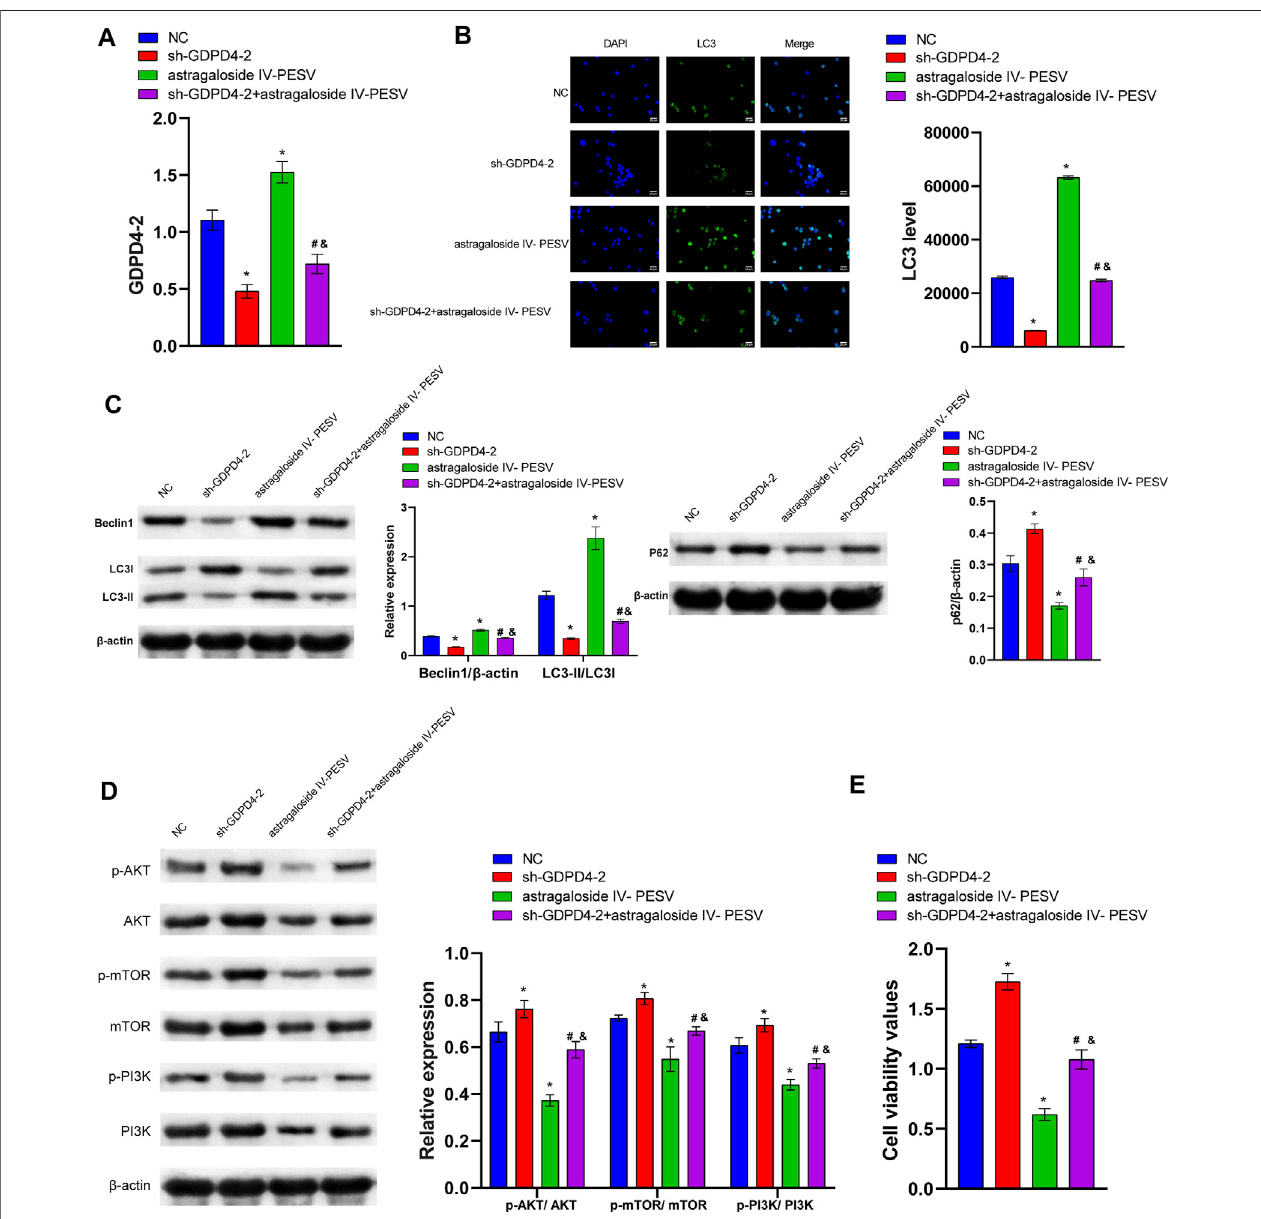
FIGURE 5 | Astragaloside IV- PESV regulated PI3K/AKT/mTOR signaling via inhibiting GDPD4-2. (A) The expression level of GDPD4-2. (B) LC3 and DAPI immuno fl uorescence staining were performed to detect autophagy. (C) The LC3, Beclin1, and P62 expression were determined by western blot. (D) The protein expression of the PI3K/AKT/mTOR signaling pathway. (E) Cell activity was determined by the CCK8 assay. * p < 0.05 vs. NC group, # p < 0.05 vs. sh-GDPD4-2 group, & p < 0.05 vs. Astragaloside IV-PESV group.